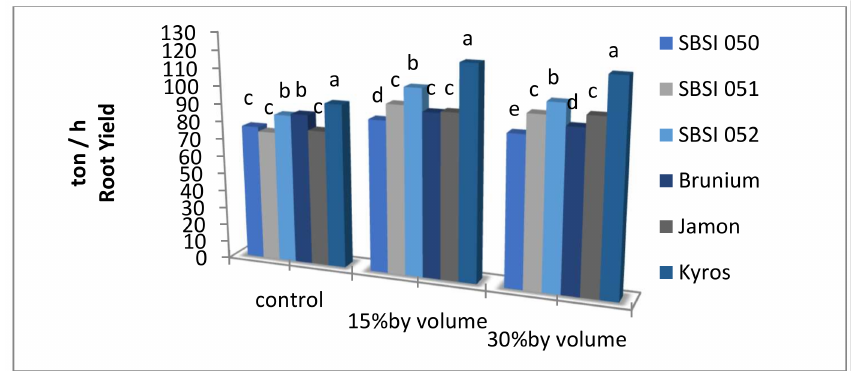
Figure 2. The interaction effect of methanol × genotype on root yield. Means followed by the same letter(s) is/are not significantly differ at 5% level of